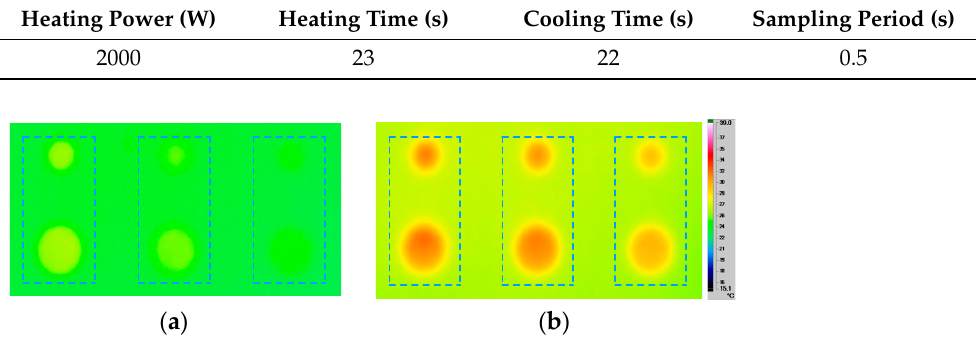
Table 2. The parameters of the experiment.